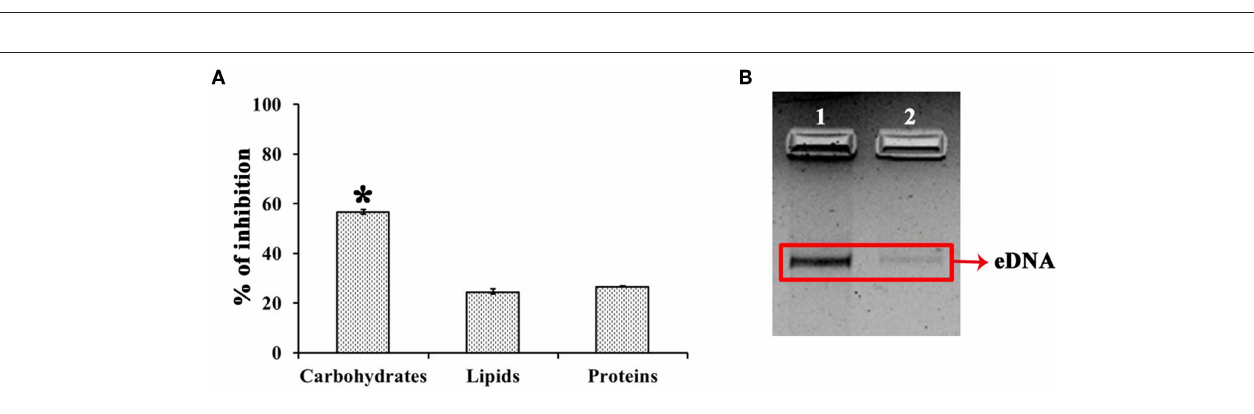
settings for impeding biofilm formation of MRSE on UMB coated